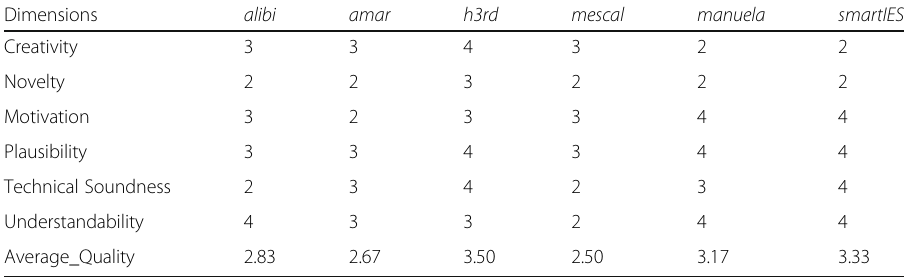
Technical Soundness 4